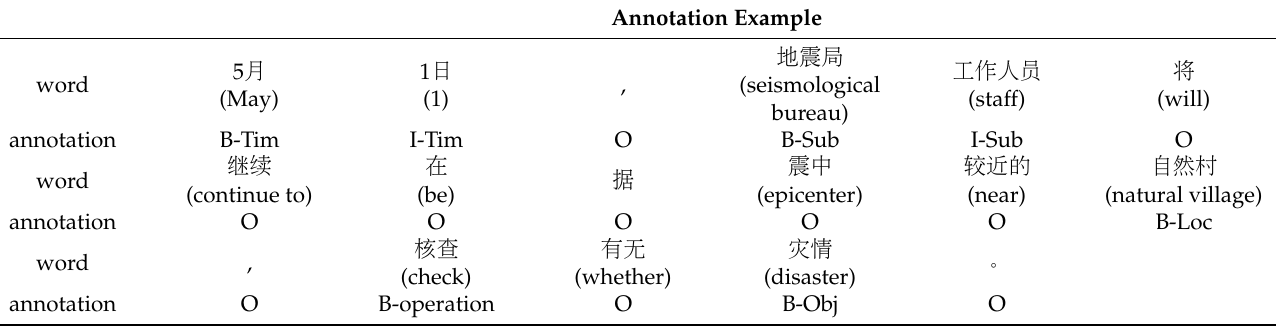
Table 2. Event Element